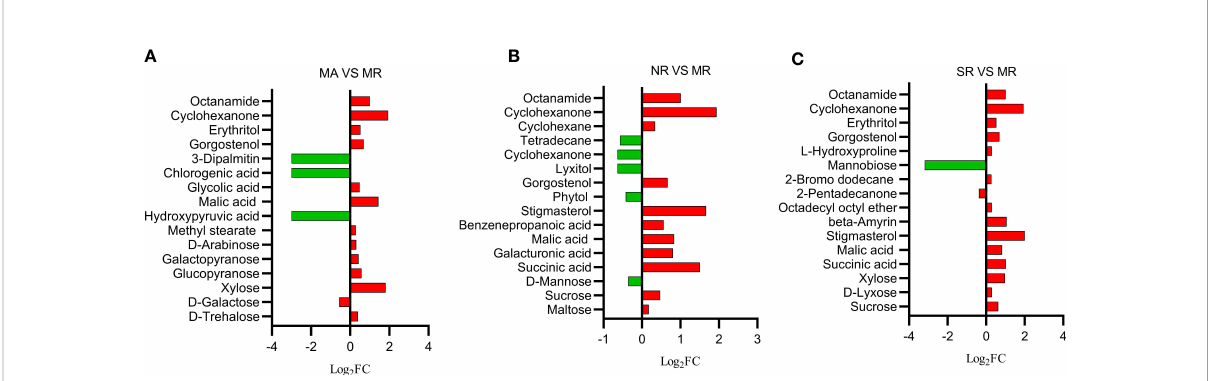
FIGURE 2 Histogram of differential soil compounds in comparison groups. The abscissa is log 2 FC of differential metabolites, and the ordinate is differential metabolites. (A) Red represents that MA is up-regulated than MR, and green represents down-regulated. (B) Red represents that NR is up- regulated compared to MR, and green represents down-regulated. (C) Red represents that SR is up-regulated than MR, and green represents